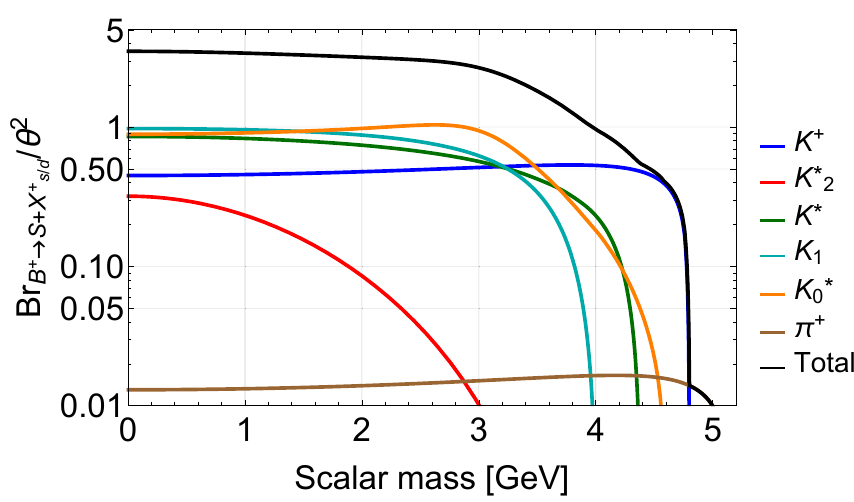
Figure 15 . Branching ratios of the scalar production in the process B one of the mesons from the caption